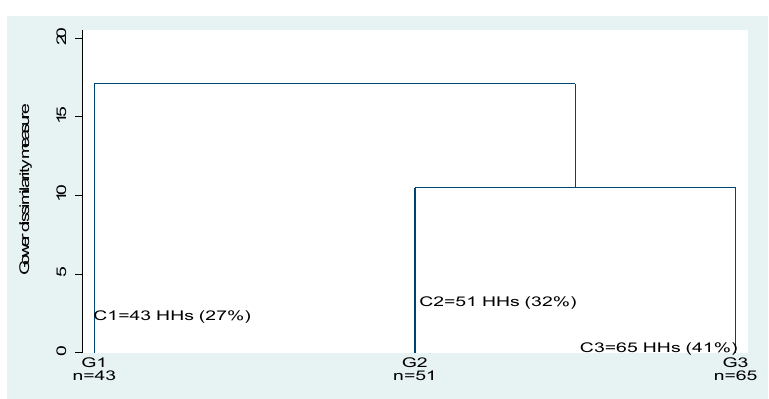
Figure A1. Note: C1 = Cluster 1(LFIS); C2 = Cluster 2 (HFIS); C3 = Cluster 3 (MFIS).